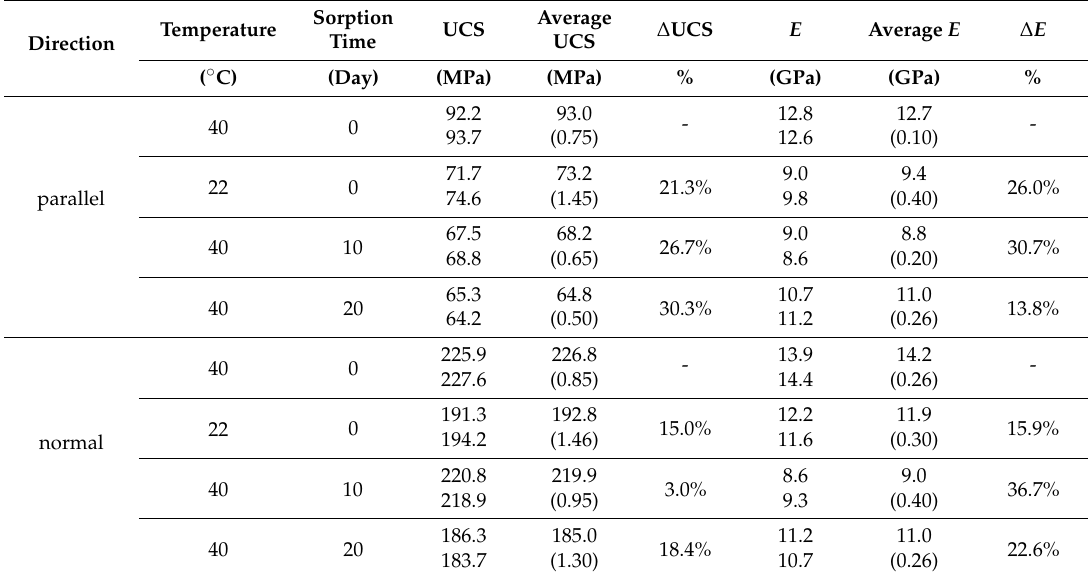
Table 1. The values of uniaxial compressive strength (UCS) and Young’s modulus (E) obtained from all the tested